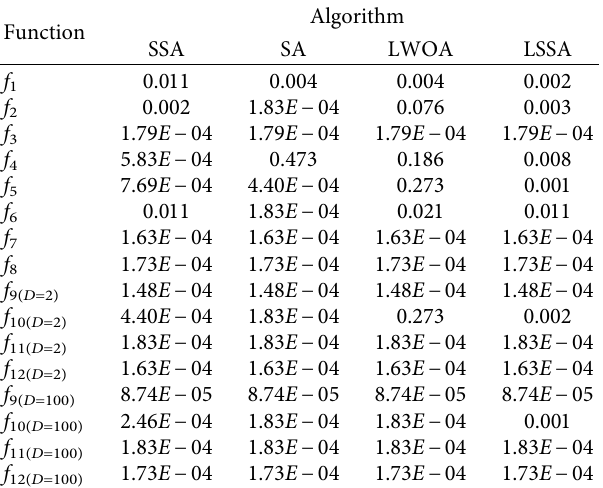
Table 4: Comparison of the Wilcoxon rank sum